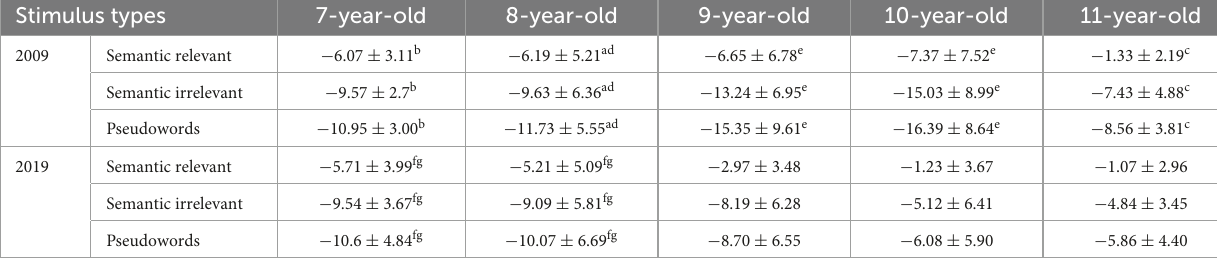
TABLE 2 N400 amplitude of children in different years and age groups ( M ± SD, µ